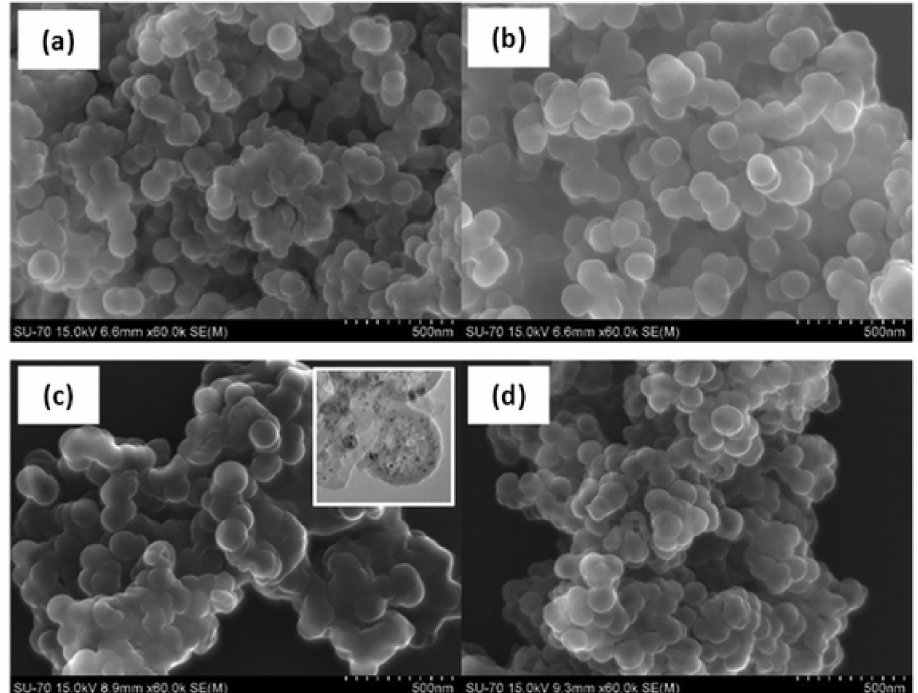
Figure 13. SEM images of: ( a ) empty SiNCs; ( b ) SiNCs with encapsulated DCOIT; ( c ) SiNCs coated with silver; and ( d ) SiNCs with encapsulated DCOIT and coated with silver. Inset: TEM image of SiNCs containing immobilized Ag nanoparticles on the surface. Figure derived from the work of Figueiredo et al. (Reproduced from [127], published by Royal Society of Chemistry,